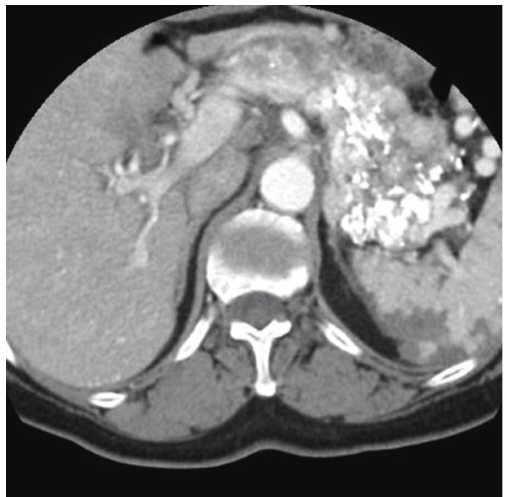
Figure 3: Contrast-enhanced axial CT scan through the pancreas after the embolization of the tumor shows multiple hyperdense embolic particles in the pancreatic tumor and also in the spleen and the right liver